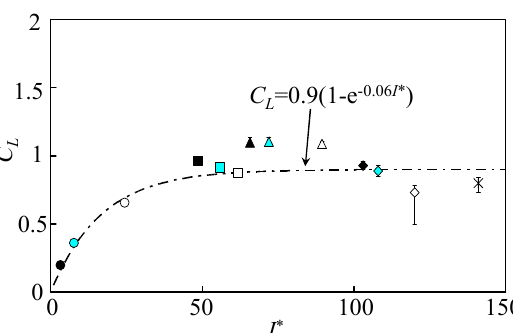
Fig. 12 Lift coefficient C L versus inertia-moment ratio I * , for several values of Reynolds number Re at